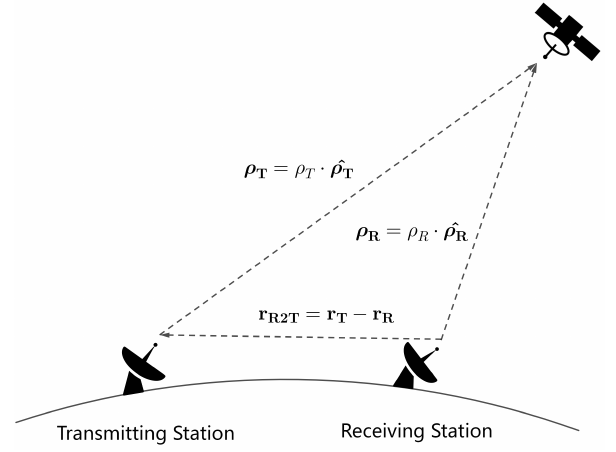
Figure 1. Bistatic radar